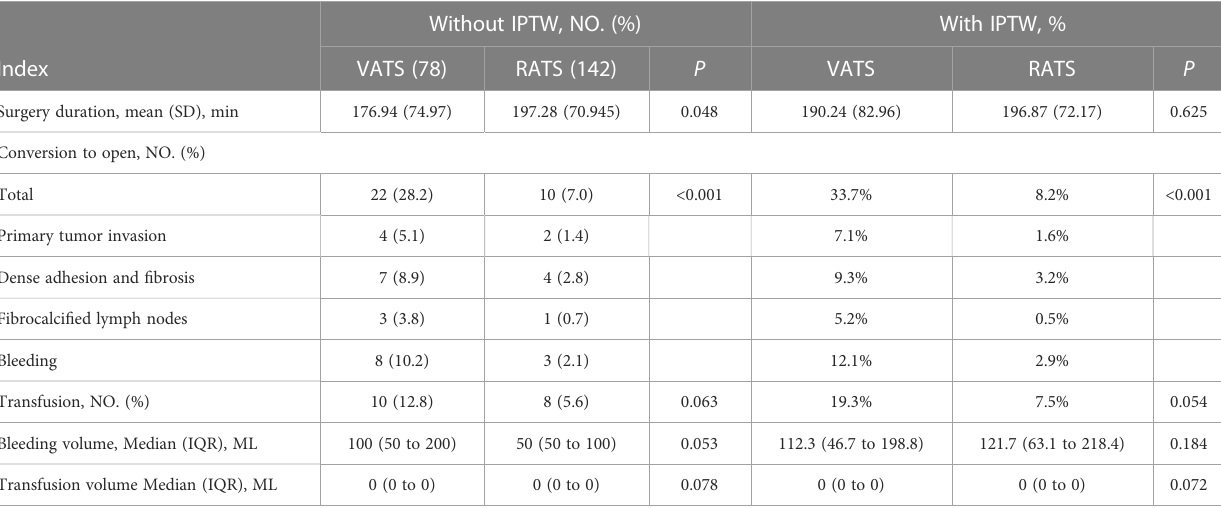
TABLE 2 Unadjusted and IPTW adjusted surgery details.